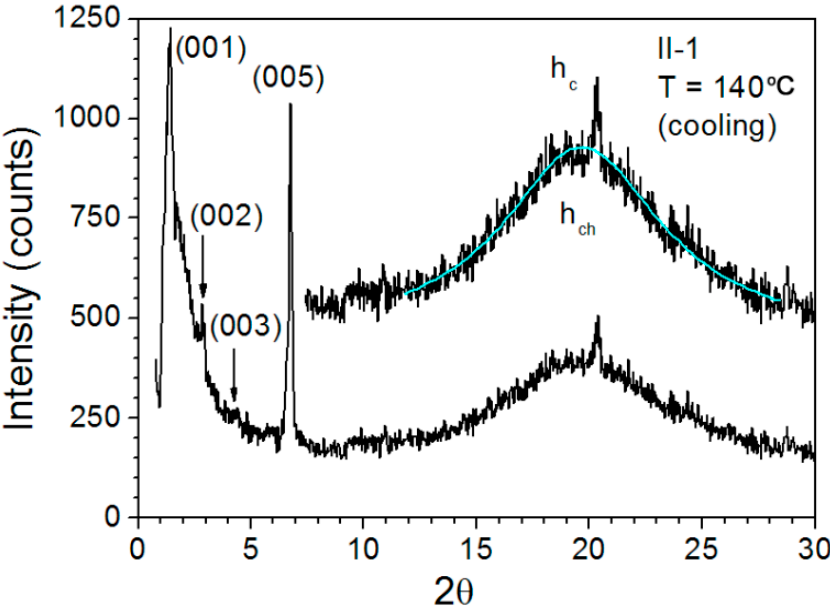
Figure 4. Small-angle X-ray di ff raction patterns for polymer II-1 registered on cooling at 140 ◦ C.